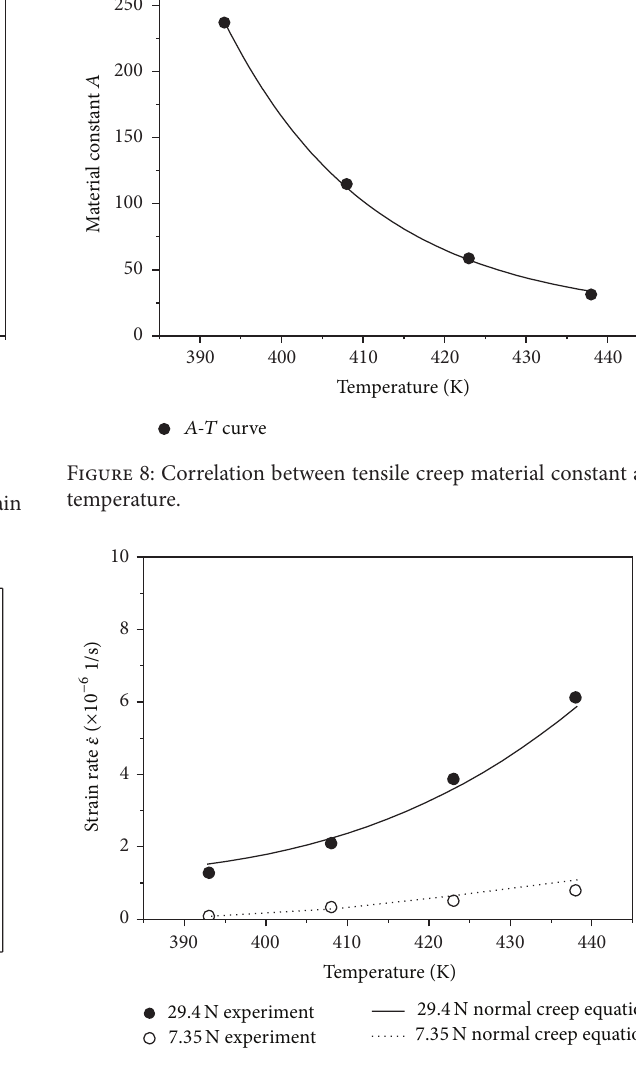
Figure 7: The correlation between logarithm strain rate and loga- rithm stress.